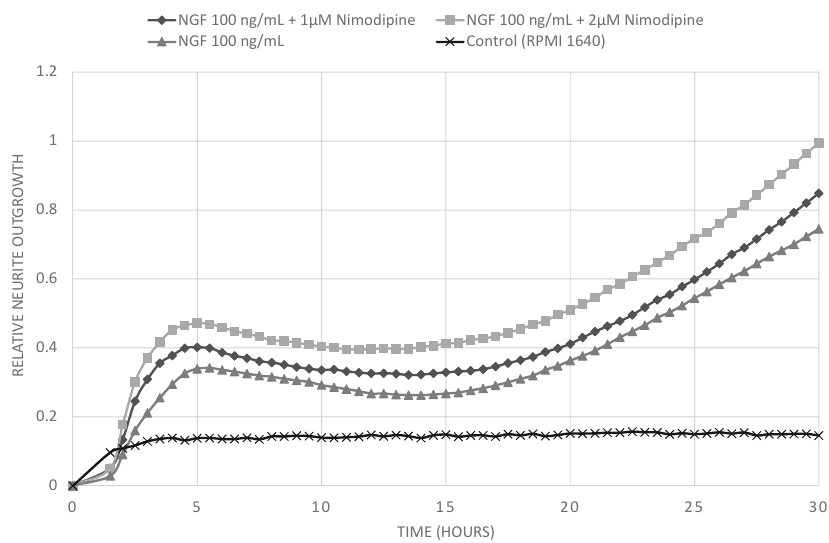
Figure 6. Measurement of realtive neurite outgrowth of PC12 cells using the xCELLigence real-time cell analyzer. Cells were treated with 100 ng/mL NGF alone or in combination with 1 µM or 2 µM nimodipine. Additionally treatment with 1 µM or 2 µM nimodipine led to dose dependent increase in of NGF induced neurite